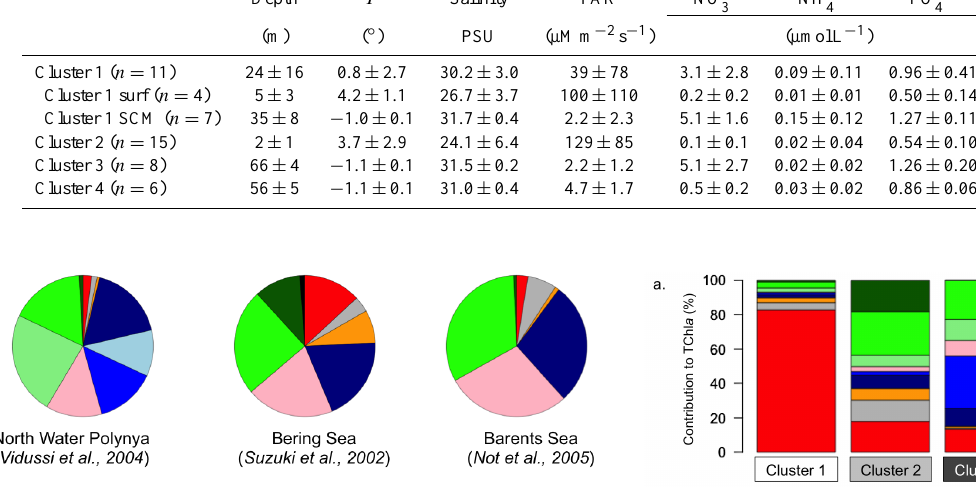
Table 4. Physical, chemical and biological characteristics (mean + SD) for each cluster presented in Fig. 4. Cluster 1 is subdivided for sam- ples collected in surface water (surf) and subsurface chlorophyll maximum (SCM) depth. PAR: µMm − 2 s − 1 of the surface photosynthetically active radiation; C / TChl a : ratio of algal carbon biomass to total chlorophyll a concentration (i.e., TChl a = Chl a + Chlid a ). Depth T